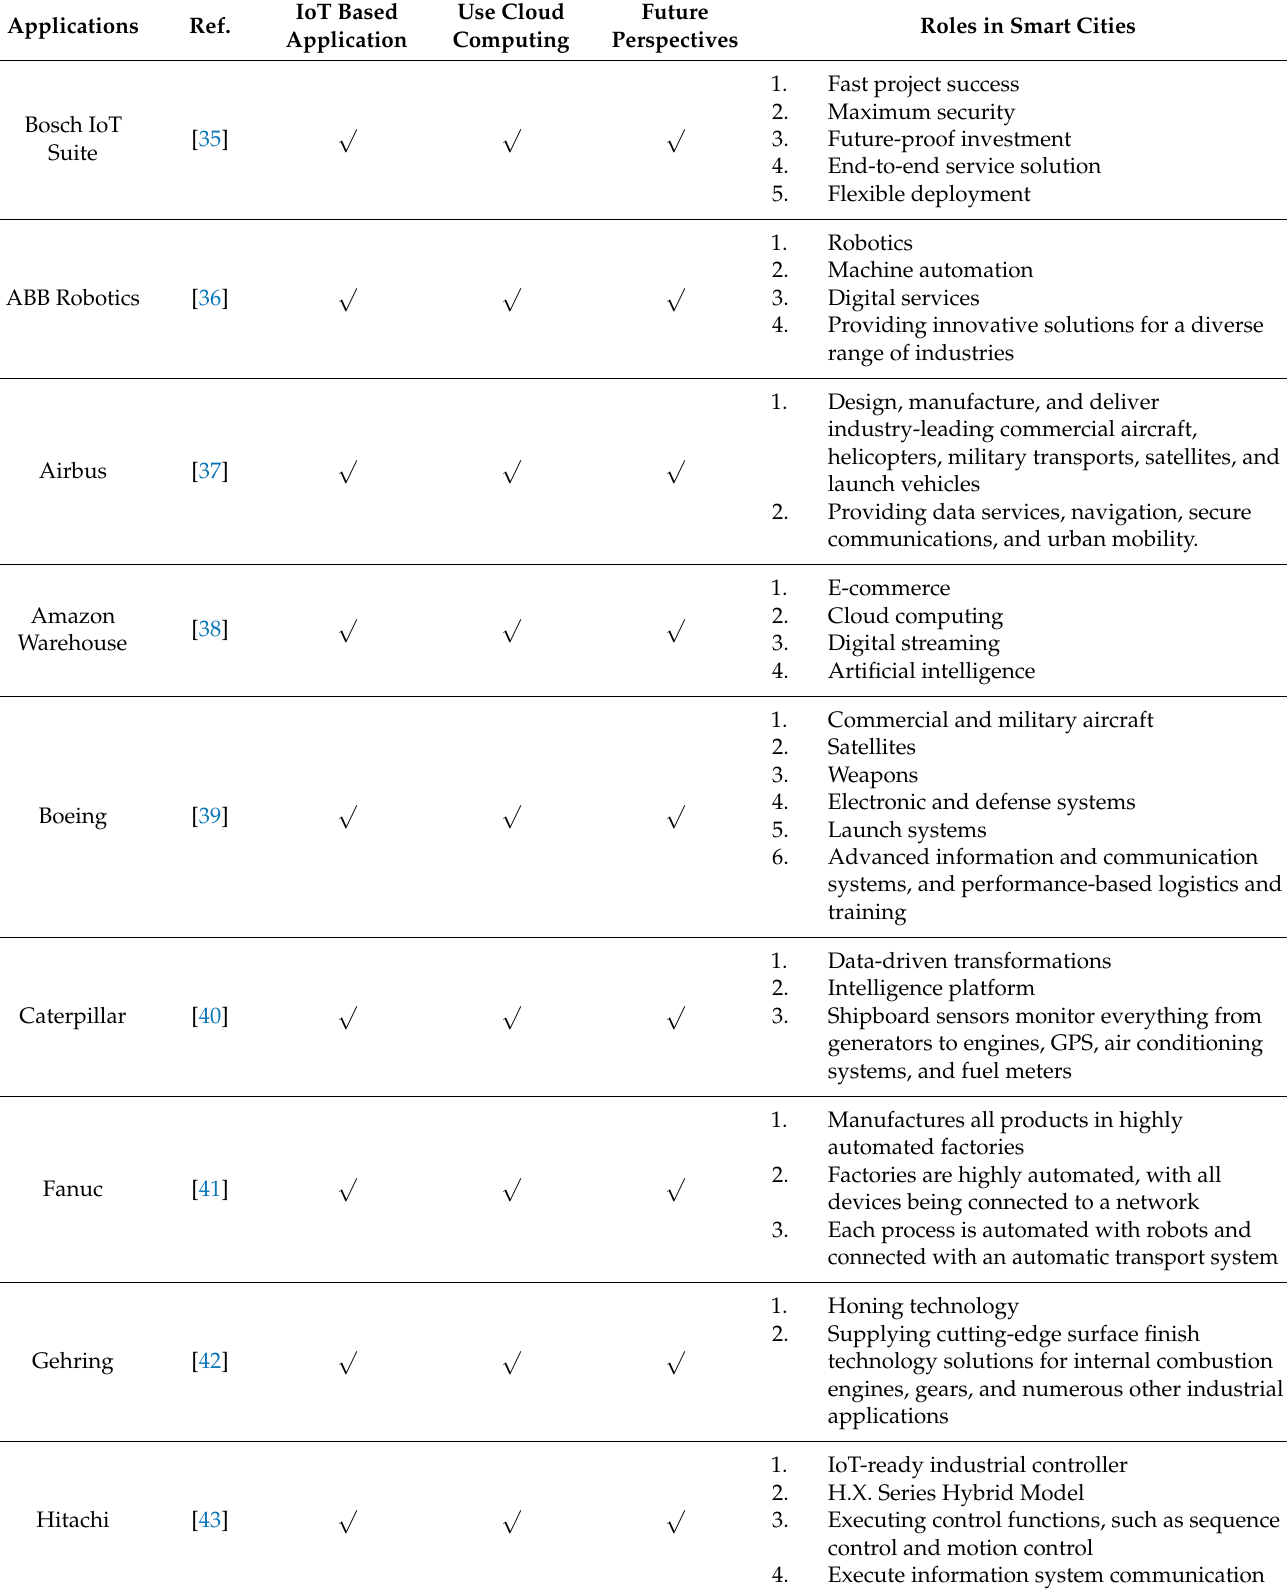
Table 2. Cloud-based IoT applications and their roles in smart